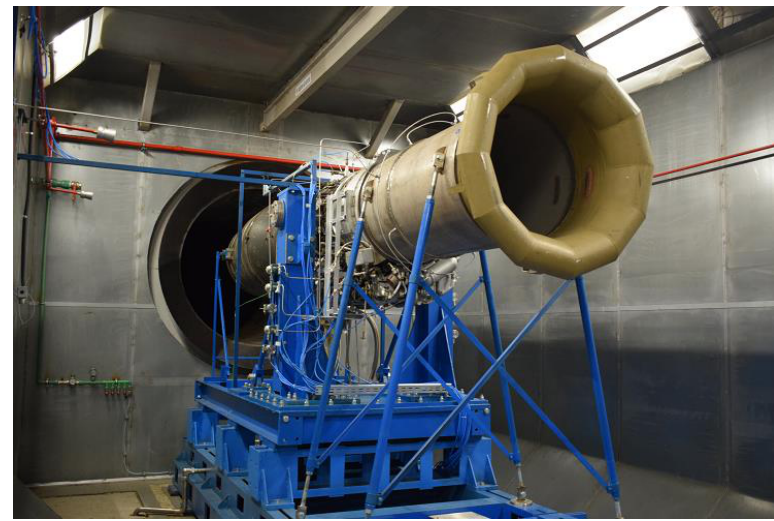
Figure 11. R-11F2-300 turbojet engine on the test bench.